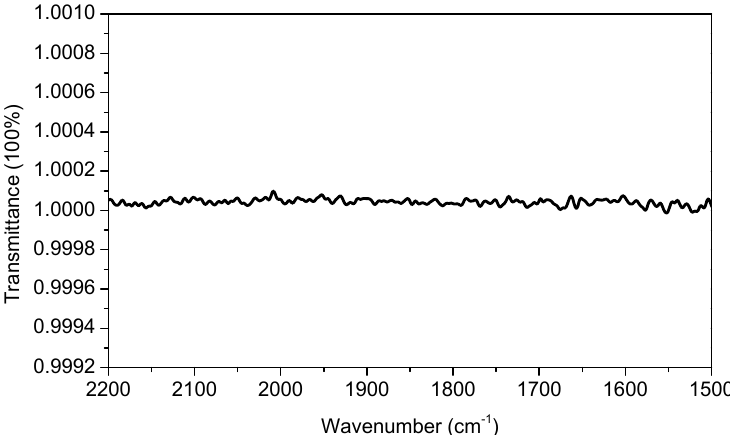
Figure 2. 100% transmittance spectrum. This spectrum was taken with an empty optical path and with closed sample compartment. The optical bench of our FTIR spectrometer is a sealed design. This spectrum can be repeatedly obtained with ease under our lab conditions. Spectral resolution: 4 cm − 1